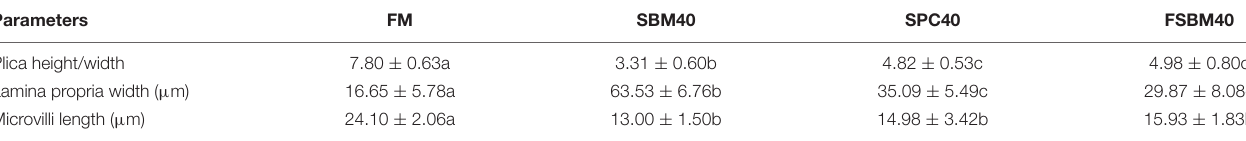
TABLE 2 | Effect of the different soy protein substitutions for fish meal protein on the enzyme activities of the pearl gentian grouper ( n = 3). Parameters